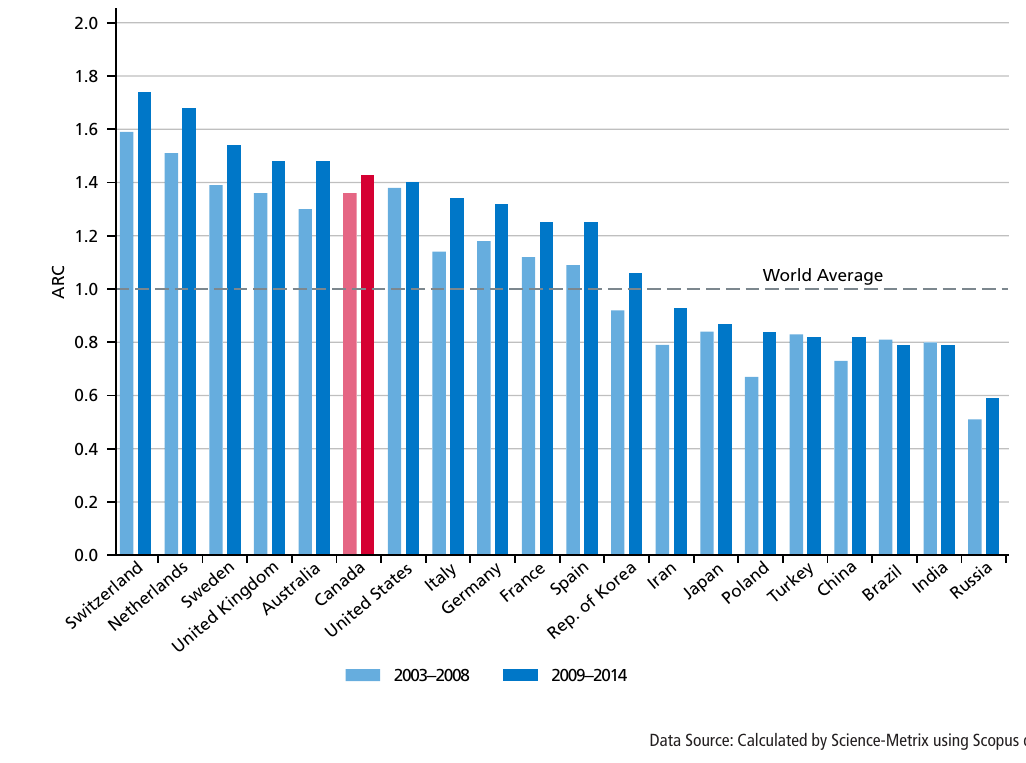
Figure 4.1 Average Relative Citation Scores for Top 20 Countries by Number of Publications, 2003–2008 and 2009–2014 Countries are ranked by ARC score for the 2009–2014